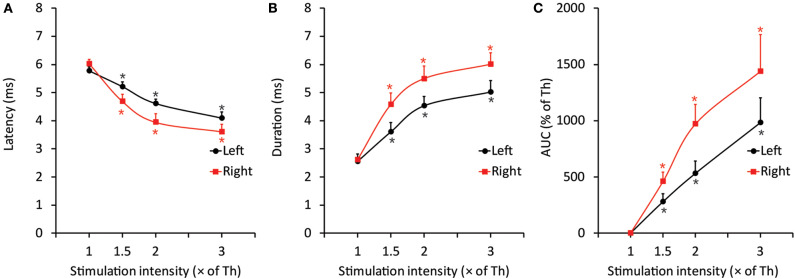
Representative data of EMG features induced by threshold and suprathreshold stimulation in the intact group after 30 s of CO2 laser irradiation to elucidate the less invasive effects of laser irradiation on the jaw-opening reflex system. (A–C) The excitability of all three EMG parameters was increased in a stimulation intensity-dependent manner and was observed as a significant decrease in latency and a significant increase in duration and AUC. The application of orthodontic force or laser irradiation did not alter the relationship between stimulation intensity and EMG excitability. Th, threshold; AUC, area under the curve. One-way ANOVA, p < 0.05. Dunnett's post hoc test, *p < 0.05 vs. “threshold”.